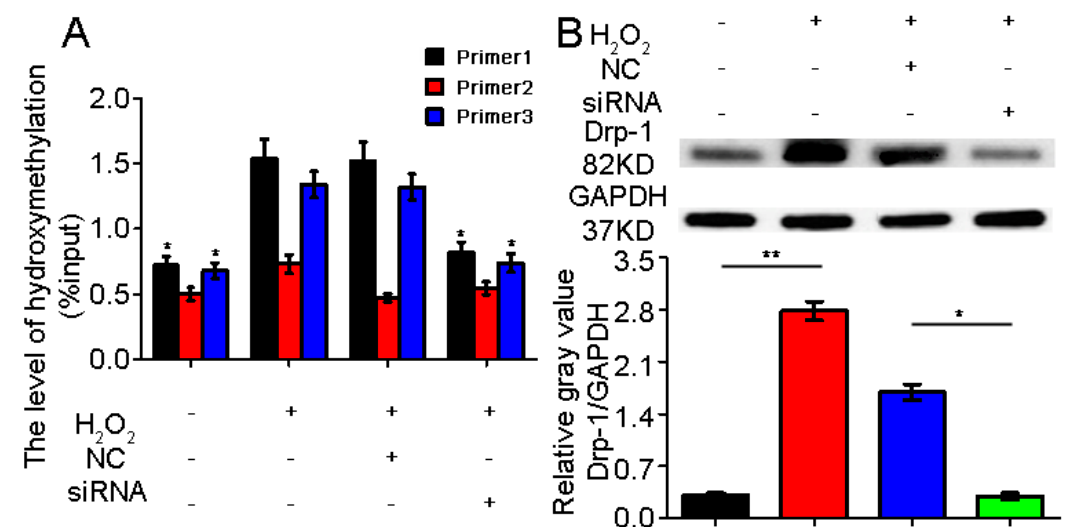
Figure 3. Effect of TET1 siRNA on the hydroxymethlation of the dynamin-related protein1 (Drp-1) promoter. ( A ) TET1 siRNA could inhibit the hydroxymethlation expression of the Drp-1 promoter compared with the H 2 O 2 group; ( B ) The Drp-1 expression decreased significantly after TET1 siRNA. NC is the negative control of TET1 siRNA. +/ − Indicates with or without reagent respectively. The data of each group are presented as means ± SD, * p < 0.05, ** p < 0.01.